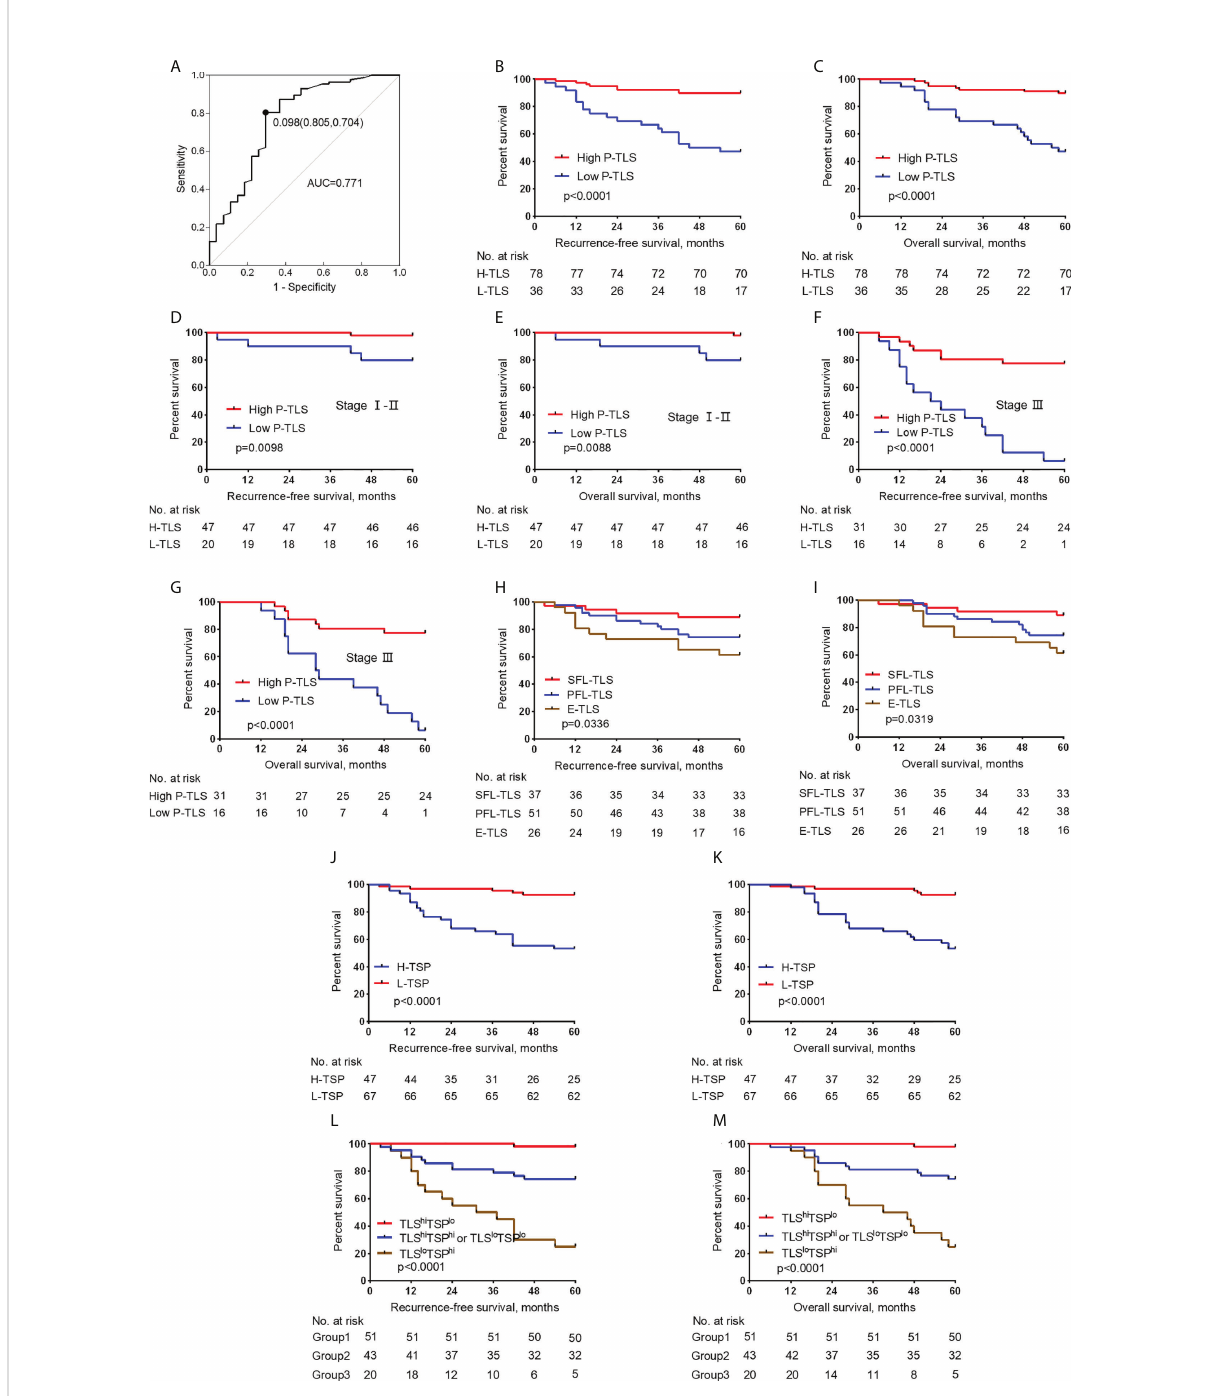
FIGURE 4 Relationship between the P-TLS and TSP and prognosis of nmCRC in the training set. (A) ROC curve of P-TLS density and patient prognosis. The optimum cut-off is 0.098, and when using this point for segmentation, the sensitivity is 0.805 and the speci fi city is 0.704. Association of the P-TLS density with RFS (B) and OS (C) , and TNM I-II (D, E) and III (F, G) CRC patients. Association of the P-TLS maturation stage with RFS (H) and OS (I) . Association of the TSP with RFS (J) and OS (K) . Kaplan-Meier survival analyses for RFS (L) and OS (M) were performed according to group 1, group 2, and group 3. Group 1: TLS hi TSP lo group, group 2: TLS hi TSP hi or TLS lo TSP lo group, and group 3: the TLS lo TSP hi